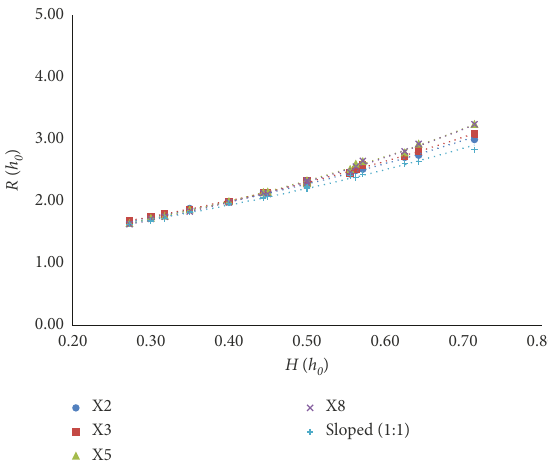
Figure 11: Model results of wave run-up for parabolic and sloped walls.